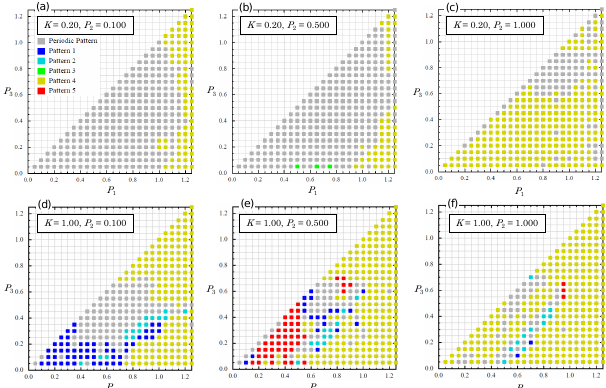
Figure 5. Phase diagrams of slip patterns for the three-block sys- tem. Periodic patterns are plotted with grey points and the others, which correspond to red points in Fig. 2, are classified into five complex patterns as described in Table